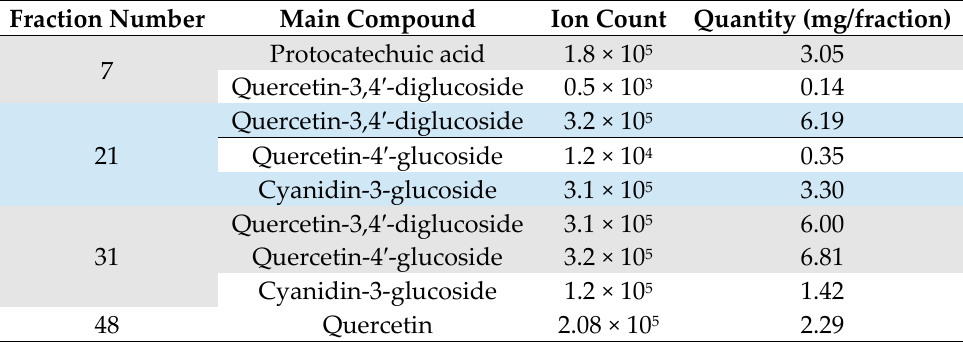
Table 2. Ion counts and quantity of the antioxidant compounds of the main fractions of red onion extract.